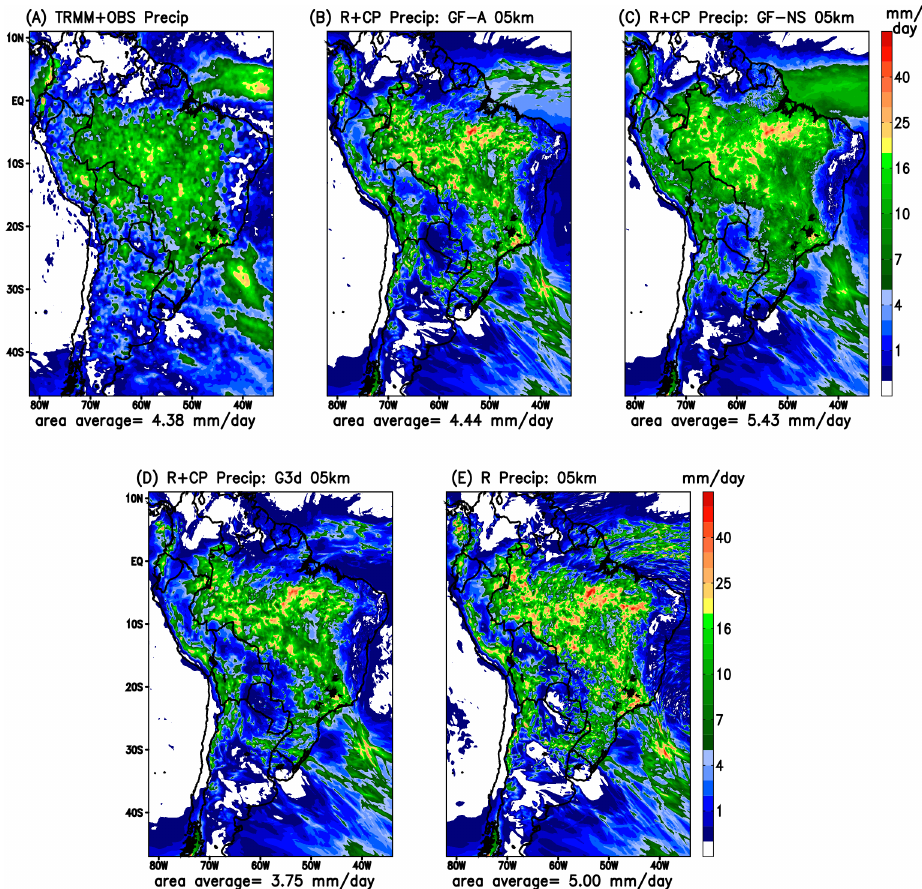
Figure 11: Comparison of averaged results using GF-A (B), G3d (D), GF-NS (C), and NO-CP (E) simulations with observations (A) derived from Raingauge and TRMM Satellite data Figure 11. Comparison of averaged results using GF-A (B) , G3d (D) , GF-NS (C) , and NO-CP (E) simulations with observations (A) derived from rain gauge and TRMM Satellite data.